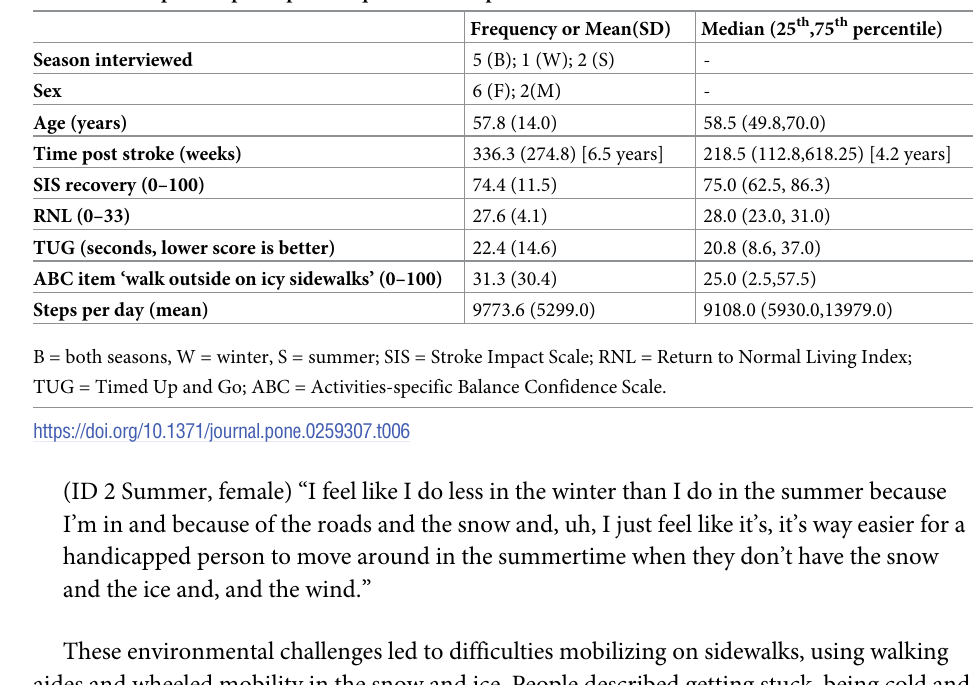
Table 6. Description of participants in qualitative component at initial assessment time.